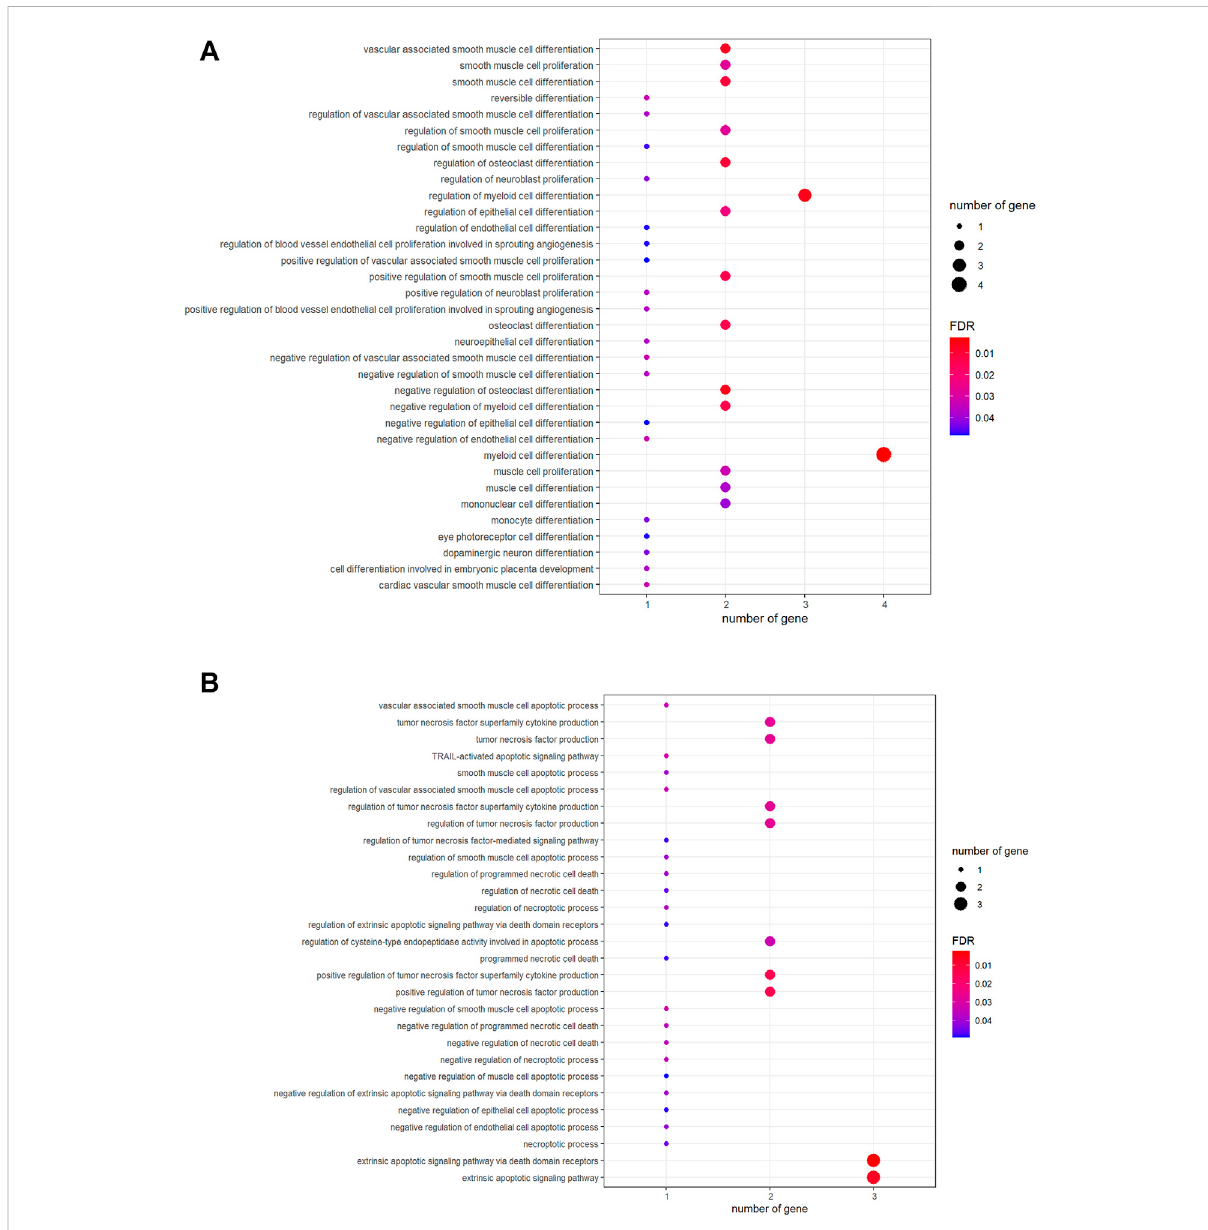
FIGURE 2 Involvement of laminarin ’ s targets in cell death and immune responses. Gene ontology enrichment analysis of laminarin ’ s targets highlighted the biological processes related to (A) cell proliferation and differentiation, (B) cell death, (C) immune responses, and (D) kinase activities.